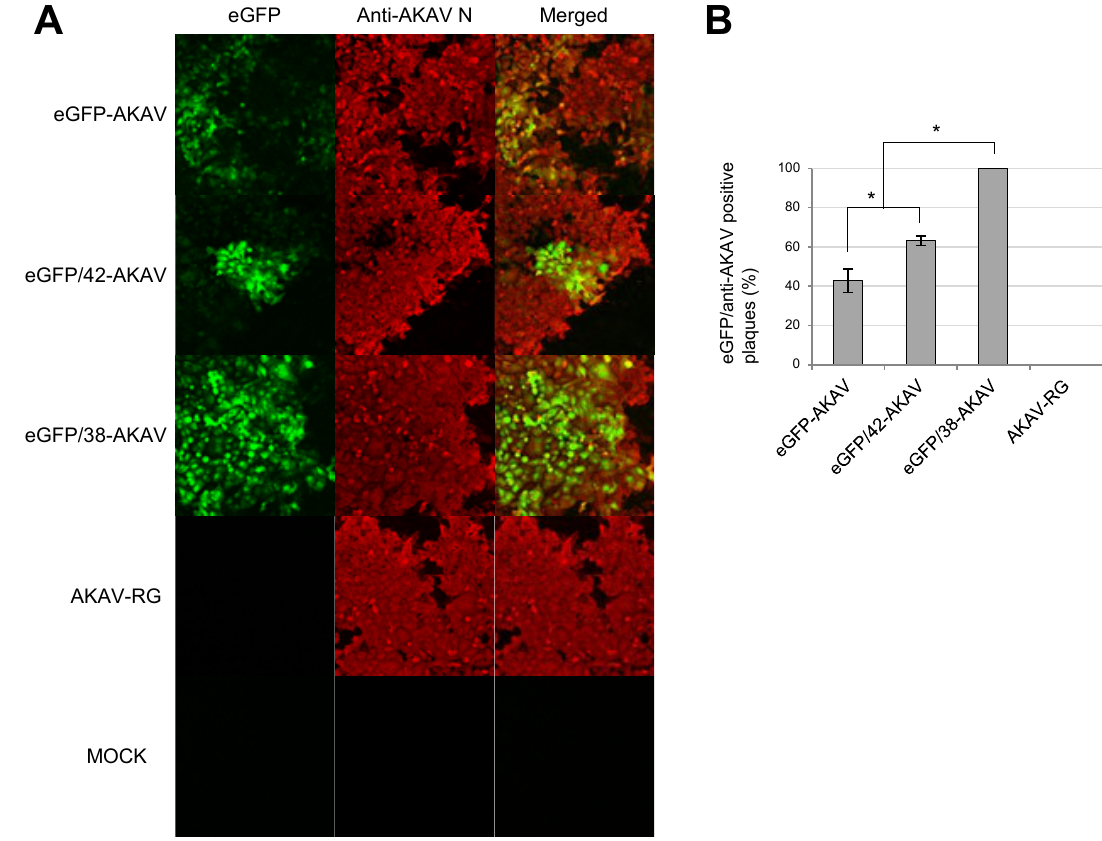
Figure 3. GFP expression of recombinant viruses. ( A ) HmLu-1 cells were infected with parent eGFP-AKAV, deletion viruses (eGFP / 42- and eGFP / 38-AKAVs), or wt AKAV-RG at a MOI of 0.01, or mock-infected. At 3 dpi, fluorescent microscopic images for the infected cells were obtained. The left panels show eGFP fluorescence (green) in cells infected with each virus or mock-infected. The middle panels show virus-infected cells detected with an anti-AKAV N mAb (red). The right panels indicate merged images with co-localization of eGFP and AKAV antigens. Magnification, × 100. ( B ) The ratios of numbers of eGFP-positive plaques to AKAV plaques were quantified. The results are presented as the mean ± SD (error bars) from 4–5 wells. *, p < 0.05, **, p < 0.01; Mann–Whitney U